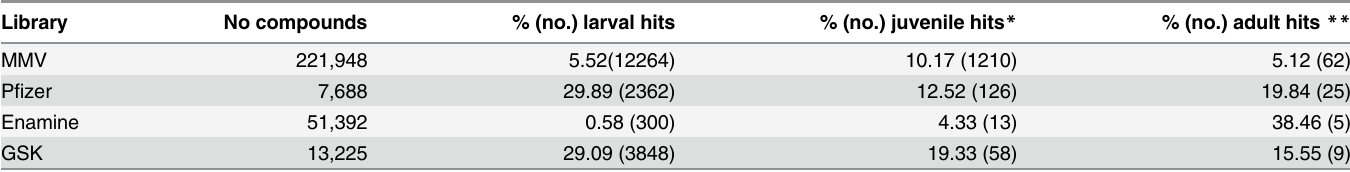
Table 2. Hit rates for compound